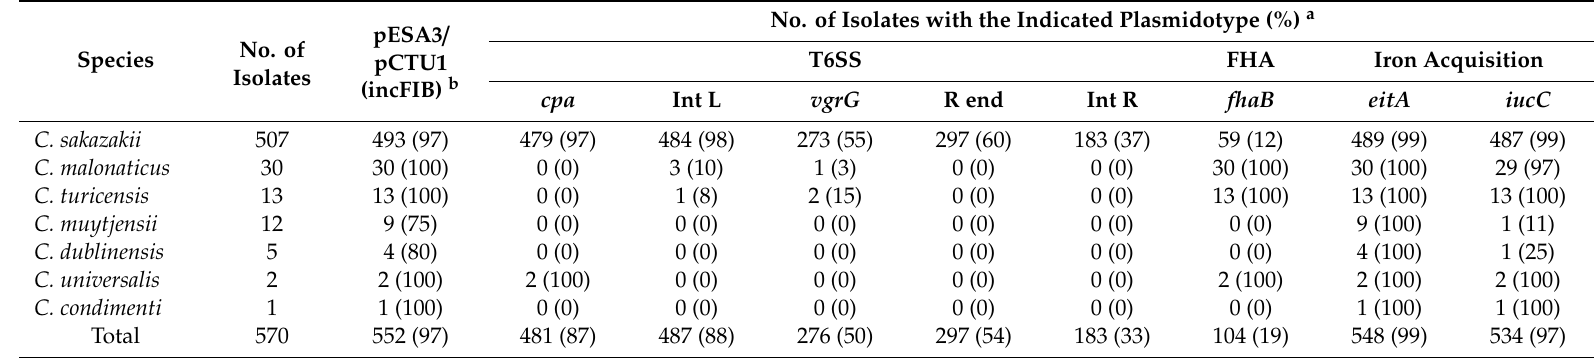
Table 5. Prevalence and distribution of virulence factors harbored on the pESA3 / pCTU1 / pSP291-like incFIB virulence plasmid observed in 570 Cronobacter isolates. No. of Isolates with the Indicated Plasmidotype (%) a pESA3 / Species No. of T6SS FHA Iron pCTU1 Isolates (incFIB) b